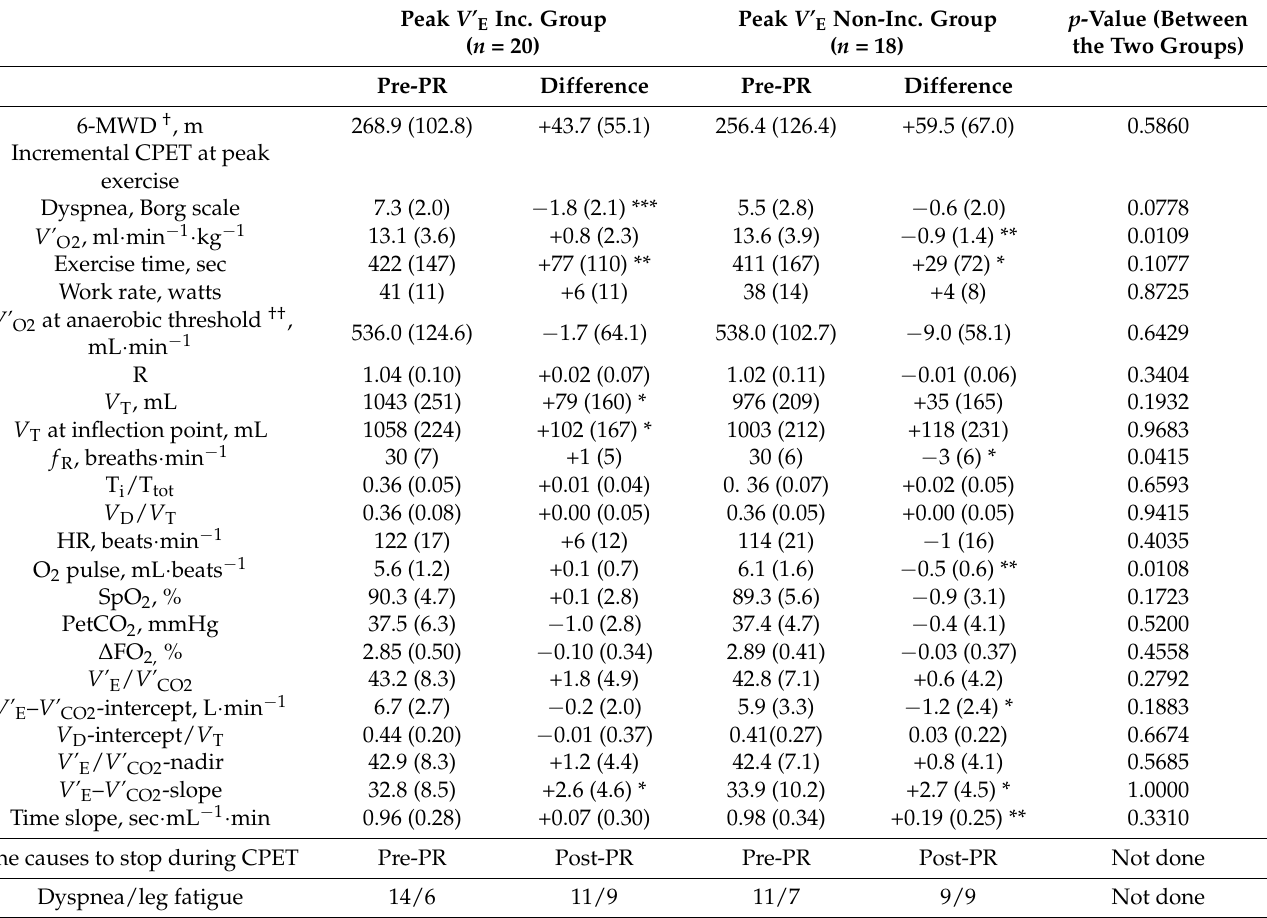
Table 5. Changes in the results of exercise testing after pulmonary rehabilitation in the peak V’ E increase and non-increase